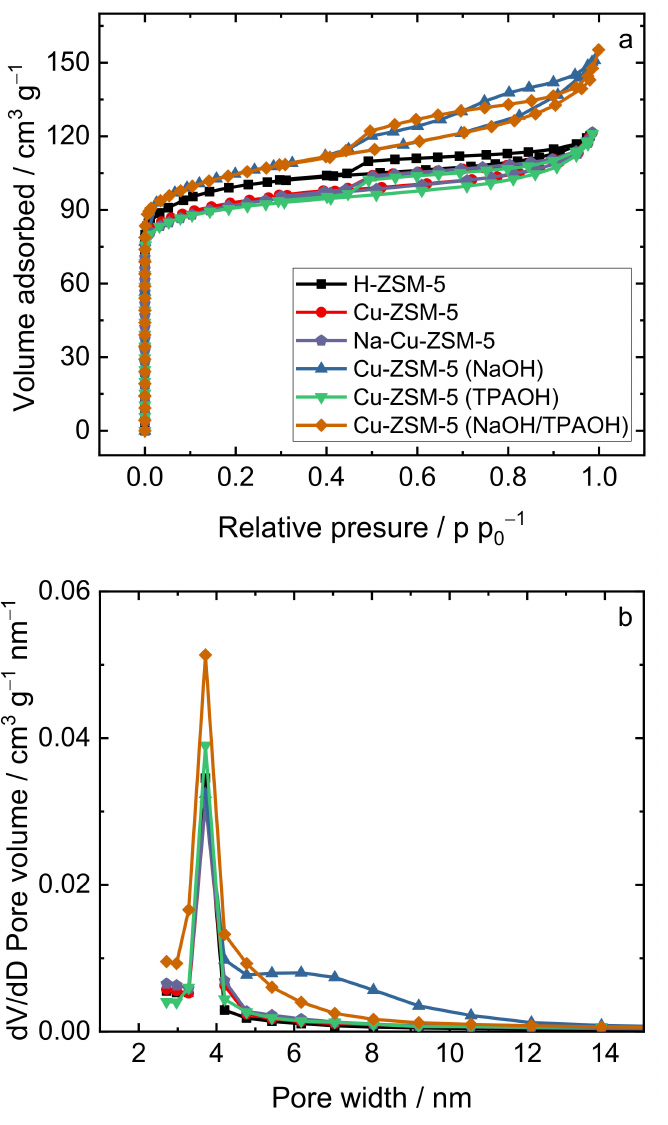
Figure 3. ( a ) N 2 -adsorption isotherms and ( b ) pore size distribution of H-ZSM-5, micro-/mesoporous Cu-exchanged ZSM-5 and Cu-exchanged ZSM-5 with co-cation. Table 3. Textural properties of the samples determined from the N 2 -adsorption measurements: specific surface area (as (BET)), micropore pore volume (V MIC ), mesopore pore volume (V MES ) and total pore volume (V TOT